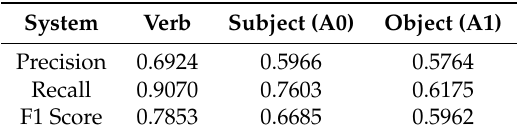
Table 10. Performance of proposed system on Data set 1.